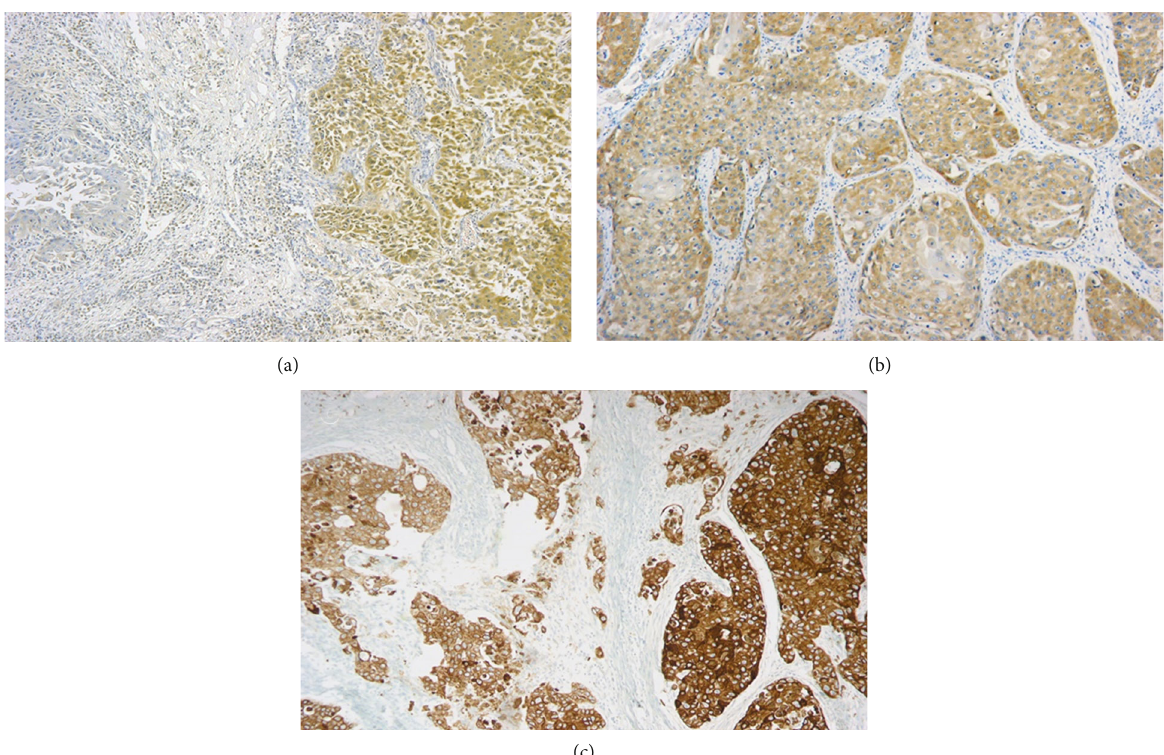
Figure 4: Heterogenous expression of IMP3 in IP-associated sinonasal SCC: (a) in well-di ff erentiated SCC, negative areas of tumor were seen alternating with areas of moderate intensity in well-di ff erentiated SCC (IHC × 100); (b) in moderately di ff erentiated sinonasal SCC, focal strong cytoplasmic staining alternate with foci of cytoplasmic staining of low intensity (IHC × 100); (c) poorly di ff erentiated SCC showed di ff use moderate to strong cytoplasmic staining (IHC × 100). Table 2: Comparison between the studied groups with regard to IHC expression of IMP3 and Ki-67 values. Group P SigNormal epithelium Inverted papilloma SCC